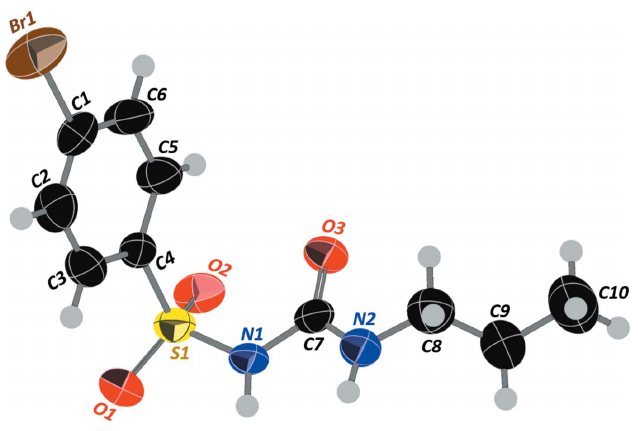
Figure 1 The molecular structure of 4-bromo- N -(propylcarbamoyl)benzene- sulfonamide with atomic numbering scheme. Displacement ellipsoids are drawn at the 50% probability